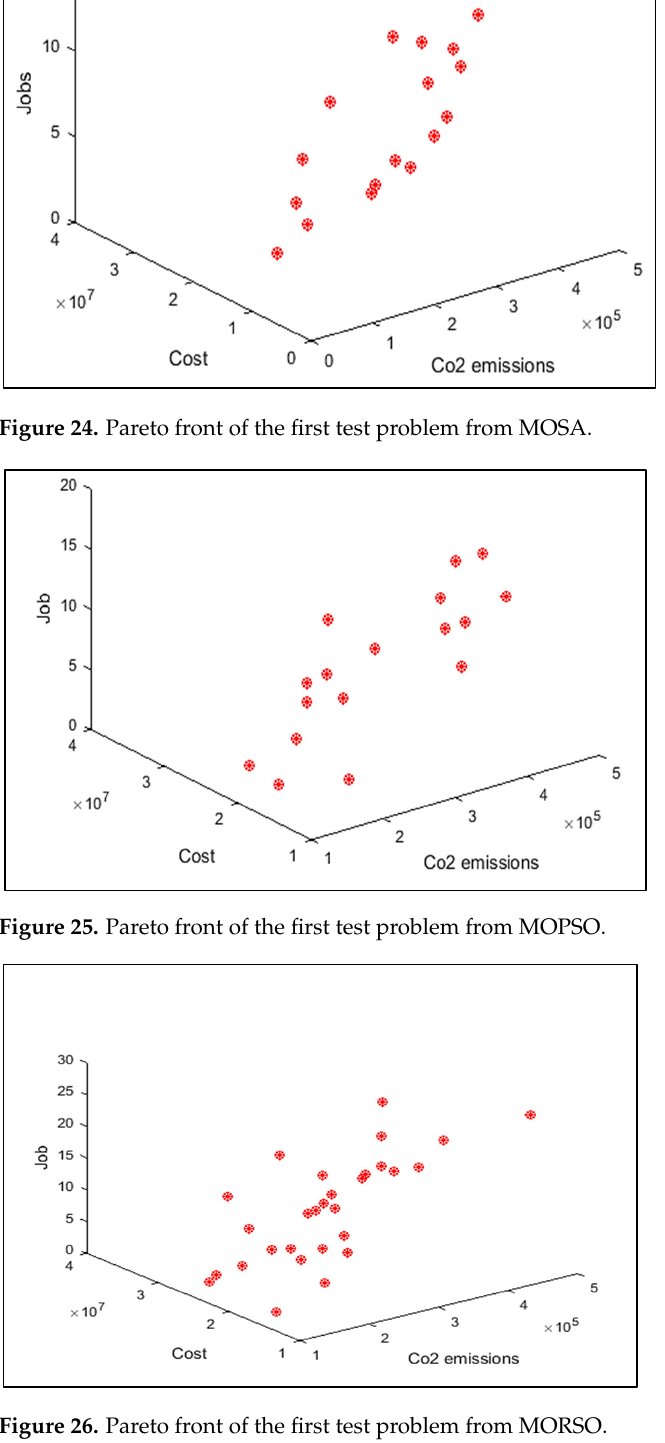
Figure 26. Pareto front of the first test problem from MORSO.